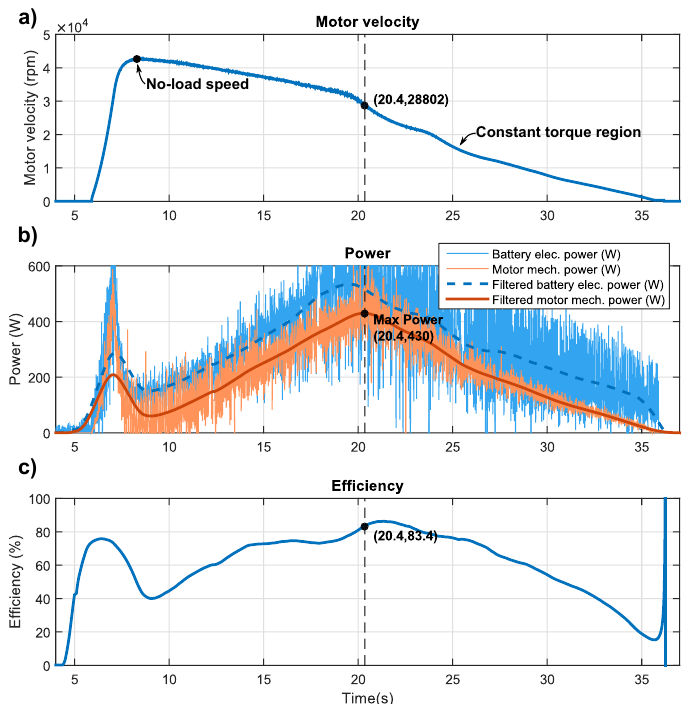
Figure 12. This figure shows the maximum mechanical output power (430 W at 83.4% efficiency) achievable using the maximum liquid-cooled steady-state current of 9.65 A. These data were obtained by setting a constant motor current and then varying the motor’s load from zero load to a fixed load.